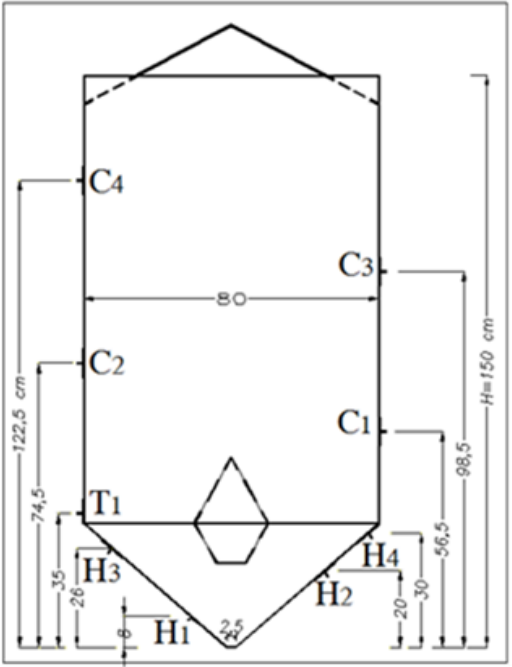
Figure 2: The measuring cell